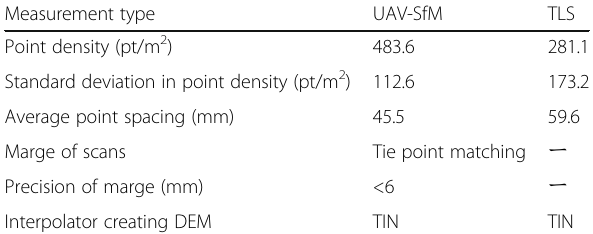
Table 1 Point cloud properties acquired via UAV-SfM and TLS Measurement type